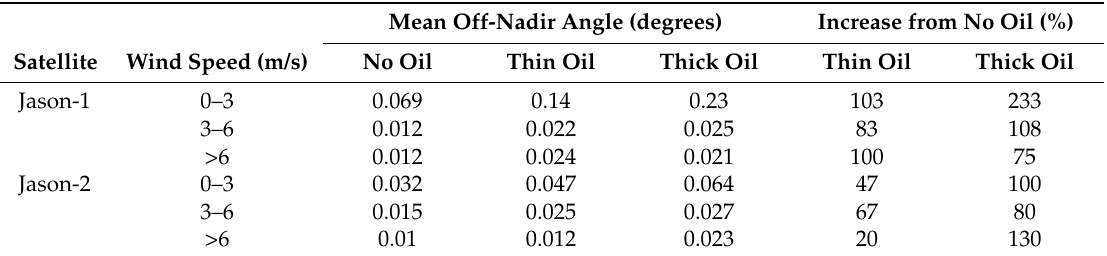
Table 7. Cheng et al. Backscatter Measurements over Deepwater Horizon